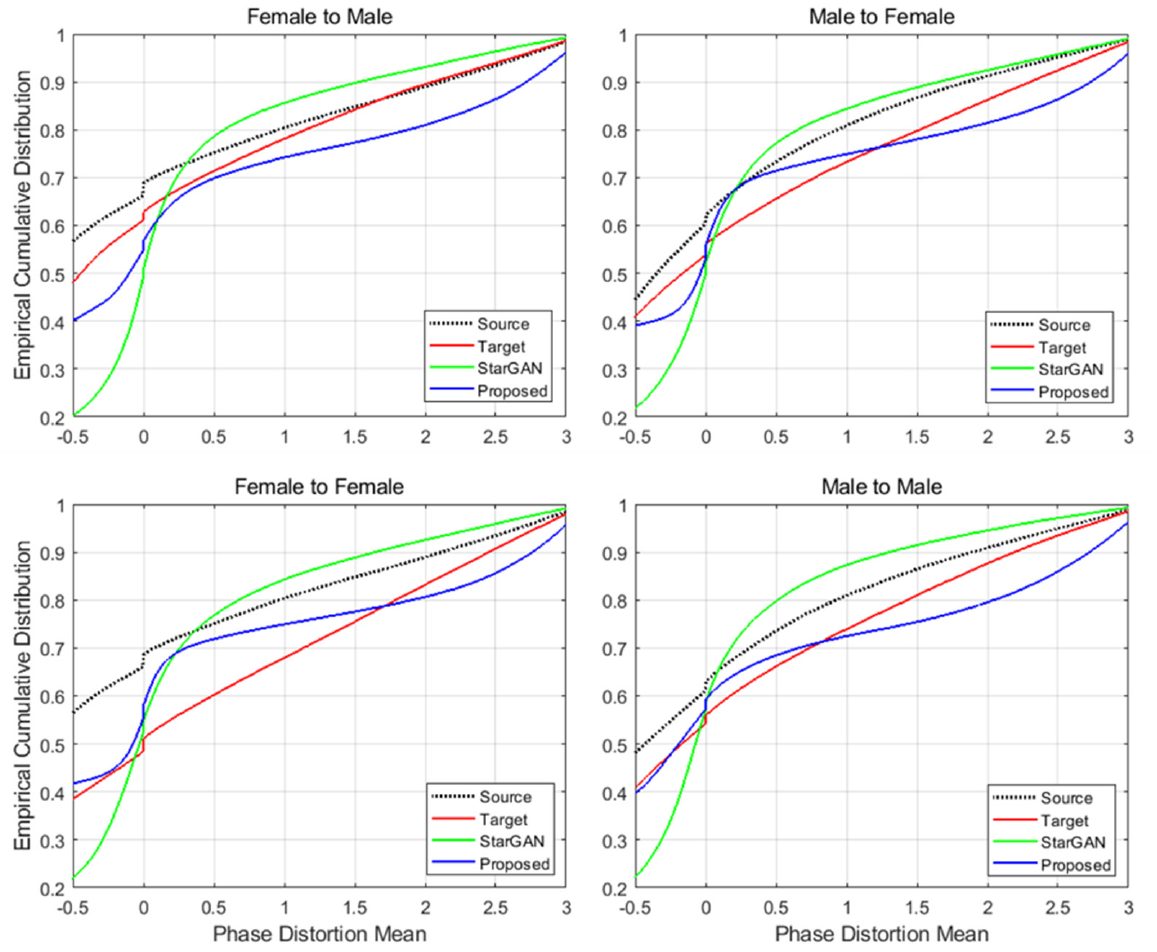
Figure 6. Empirical cumulative distribution function of PDMs using 4 types of VC pairs evaluated with the natural target speech.